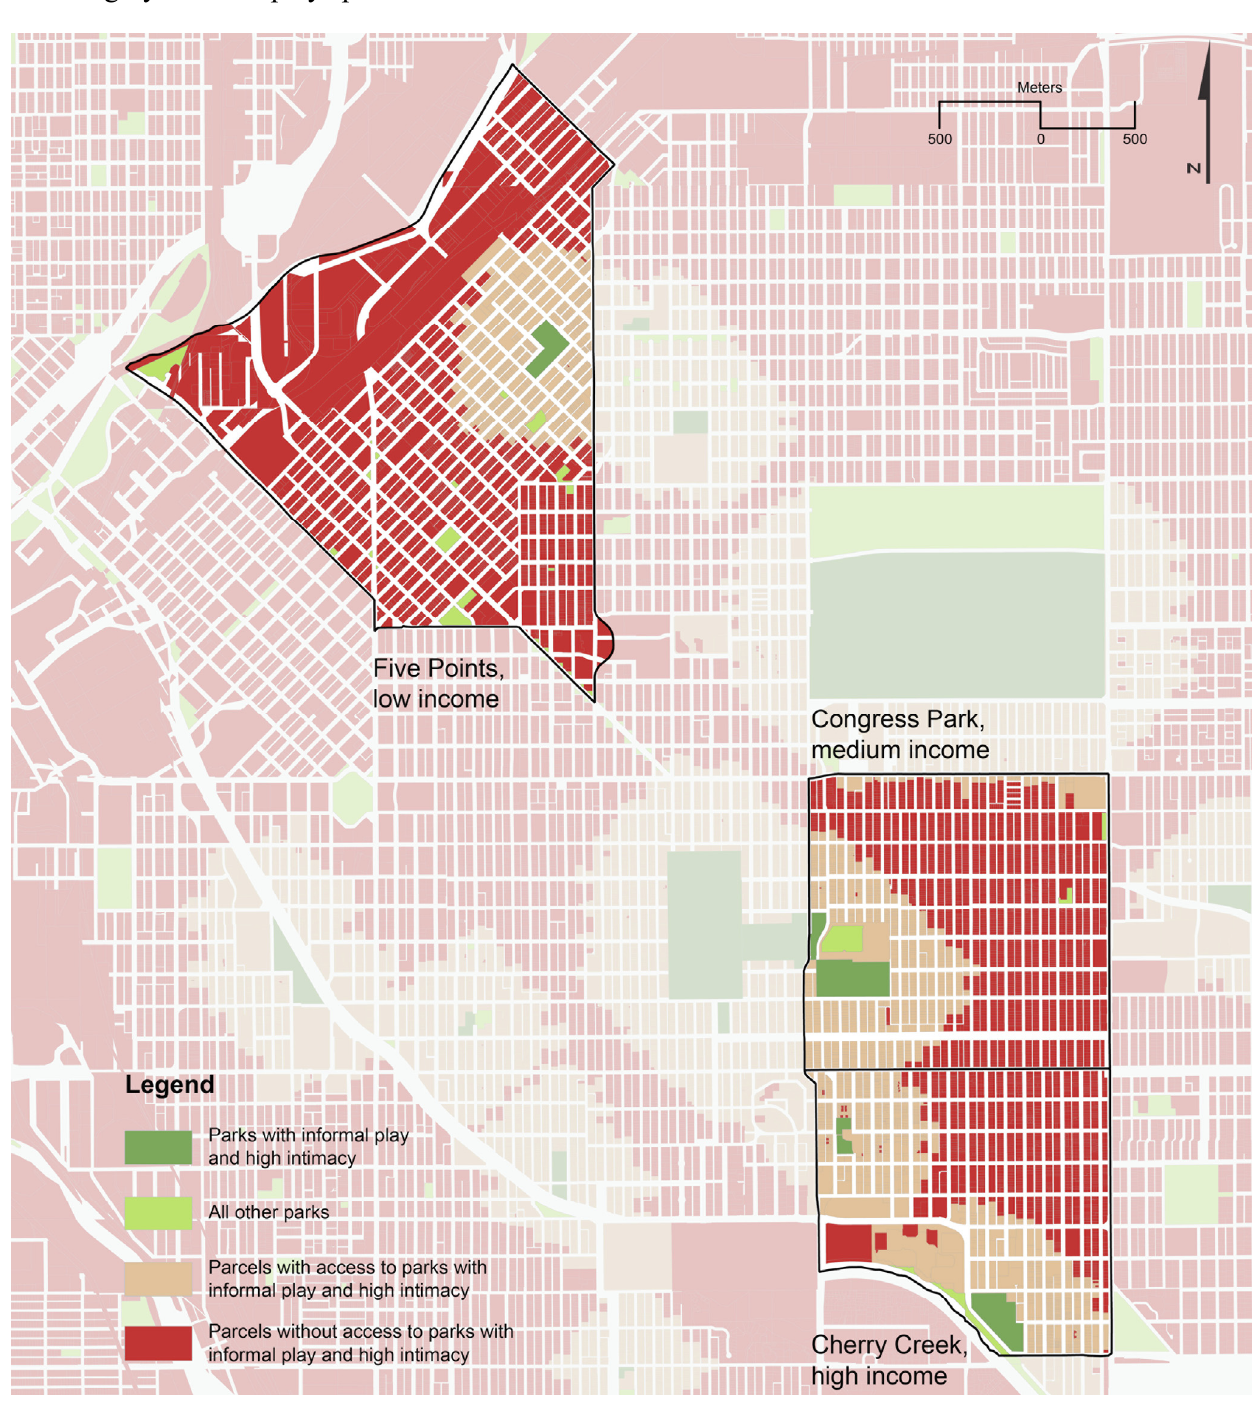
Figure 2. Cherry Creek, Congress Park, and Five Points neighborhoods access to informal, highly intimate play